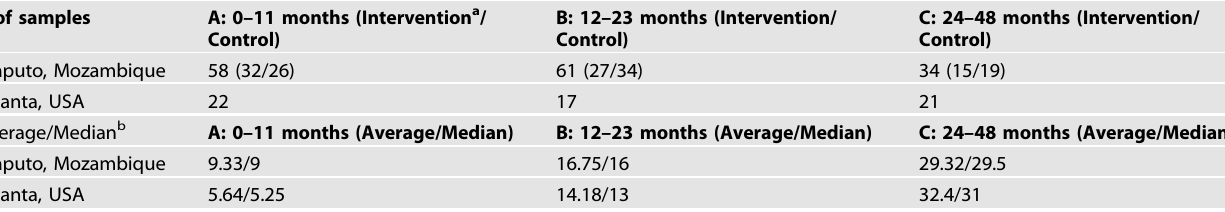
Table 1. The number of samples and average/median age for each